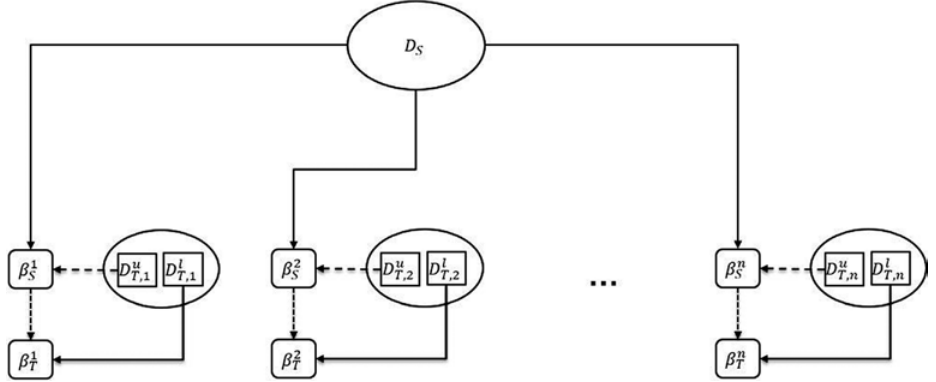
Figure 1: Structure of TELM-TDA Algorithm with M Target